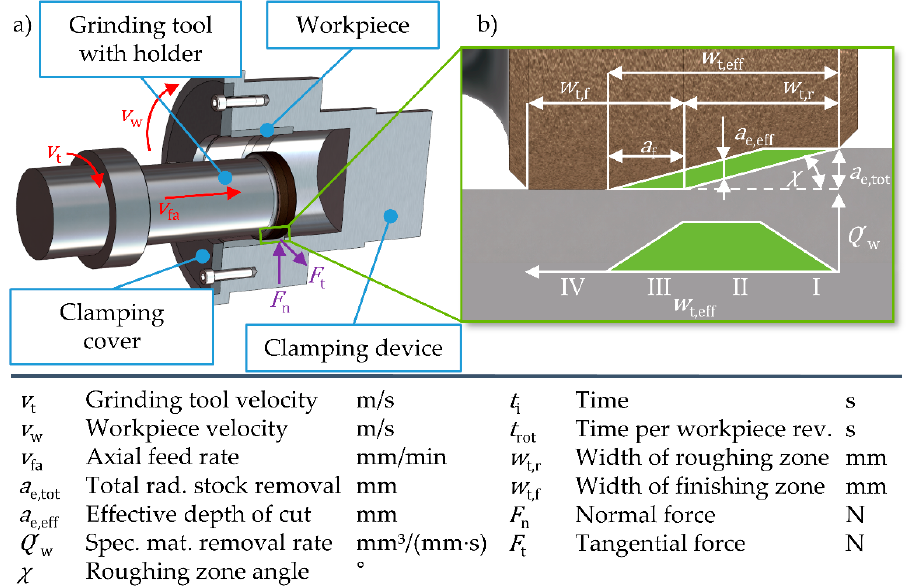
Figure 1. ( a ) Process kinematics of internal traverse grinding and clamping of workpiece; ( b ) macro- scale engagement section and relevant descriptive variables. The roughing zone angle χ is depicted exaggeratedly and measures χ = 3° for the tool used in this study.